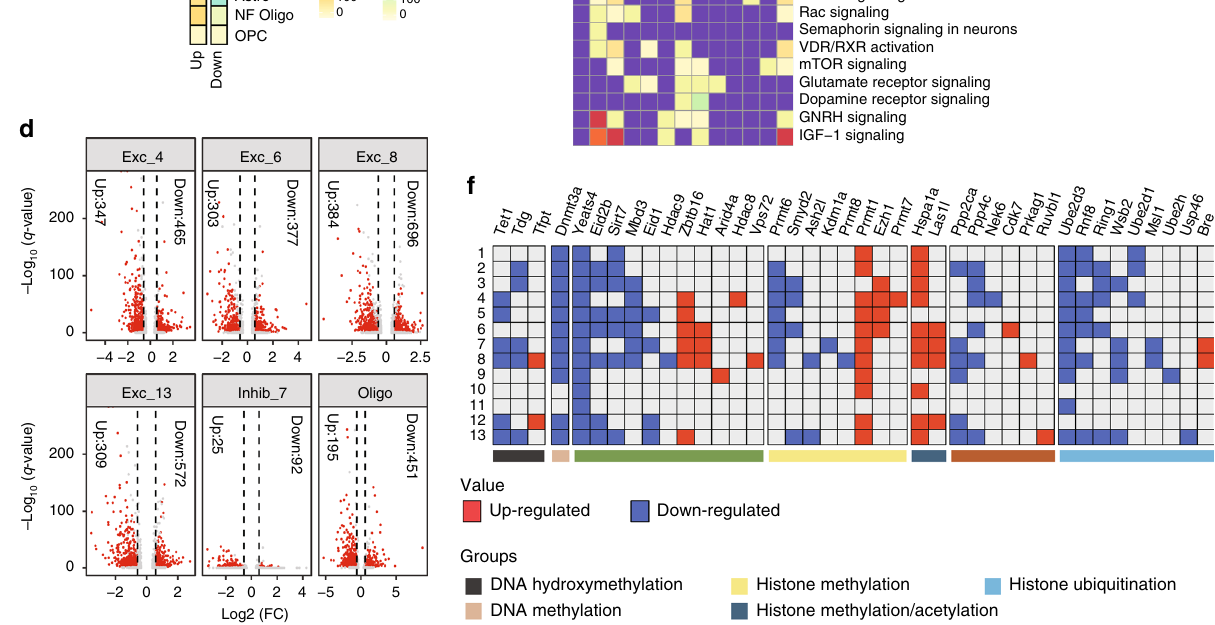
DNA hydroxymethylation Histone methylation Histone DNA methylation Histone methylation/acetylation Histone acetylation Histone phosphorylation knowledge that formation and migration of different cell types in cortex is complete by this time 19 . Comparison of gene expression in PFC of P21 with that of P60 mouse revealed dramatic changes across all cell subtypes (Supplementary Data 4). With a cutoff of 0.05 FDR and at least 50% change, expression (negative binomial generalized linear